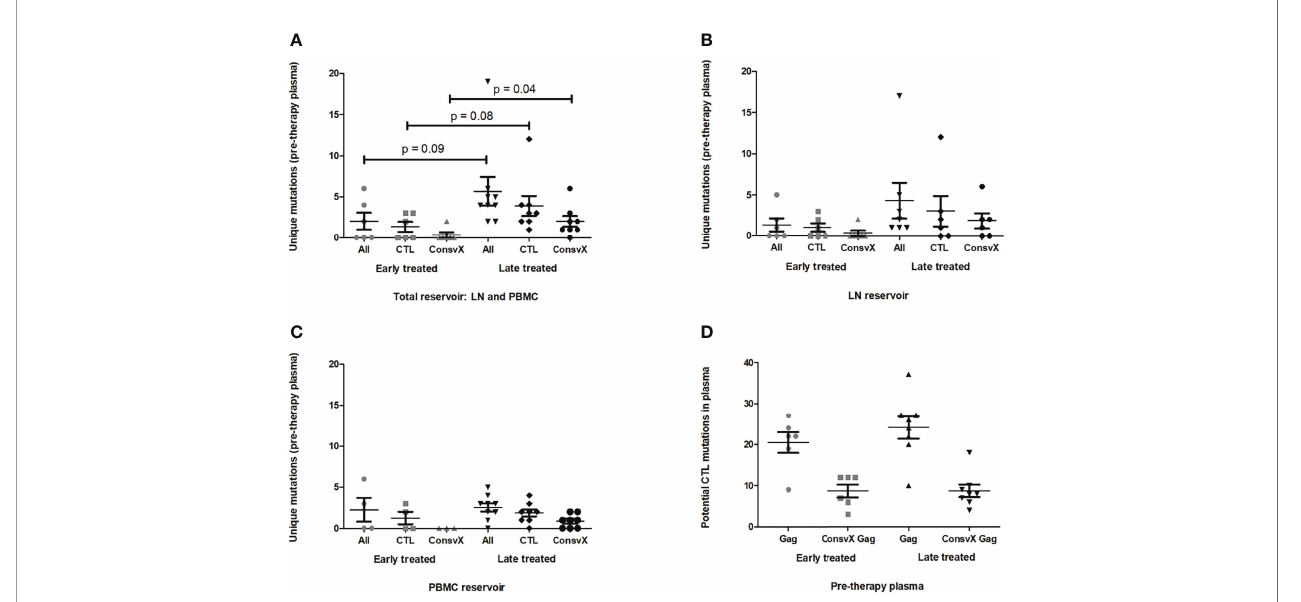
FIGURE 1 | Gag sequence differences between the reservoir variants and pre-therapy plasma variants. (A – C) Panel (A) shows the number of unique amino acid mutations in the reservoir-derived variants with respect to the pre-therapy plasma variants for individuals treated early in infection (grey) or late in infection (black). The same is shown for the subset of these unique mutations that are non-consensus and in or fl anking cytotoxic T lymphocyte (CTL) epitopes restricted by HLA-I alleles expressed by the patient i.e. potential CTL escape mutations. Also shown are potential CTL escape mutations in the HIVconsvX immunogen region only (HXB2 Gag amino acid positions 133-363 and 391-459). Panels (B) and (C) are speci fi c to the lymph nodes (LN) and peripheral blood mononuclear cells (PBMC), respectively, while panel A represents both LN and PBMC. Unique mutations are those mutations in the reservoir viruses that are not detected by single genome amplicon (SGA) sequencing and/or deep sequencing of bulk amplicons in the pre-therapy plasma virus or virus derived from peripheral blood up to one week after attainment of plasma viremia suppression. (D) The number of potential CTL escape mutations in Gag, and in the HIVconsvX immunogen region only, is shown for the pre-therapy plasma for individuals treated early in infection (grey) or late in infection (black). The Mann-Whitney U test was used to compare the different mutation categories between the early and late treated groups. Only p values less than < 0.1 are